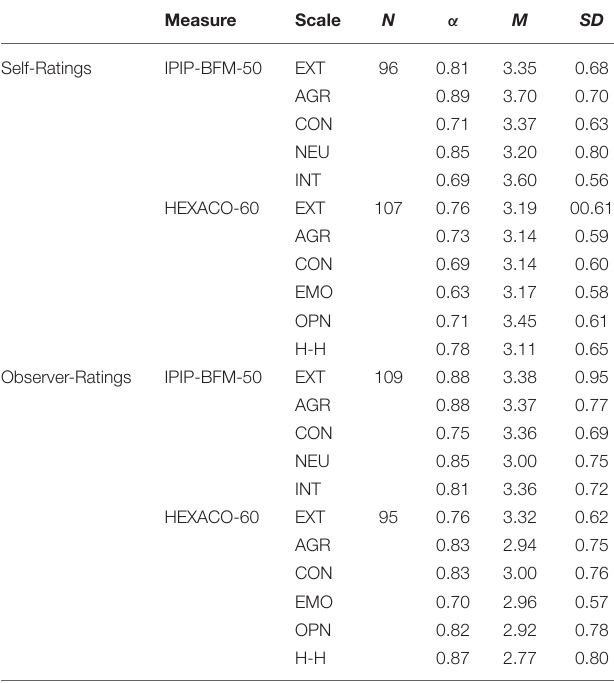
TABLE 1 | Descriptive statistics and reliability estimates for IPIP-BFM-50 and HEXACO-60. Measure Scale N α M SD